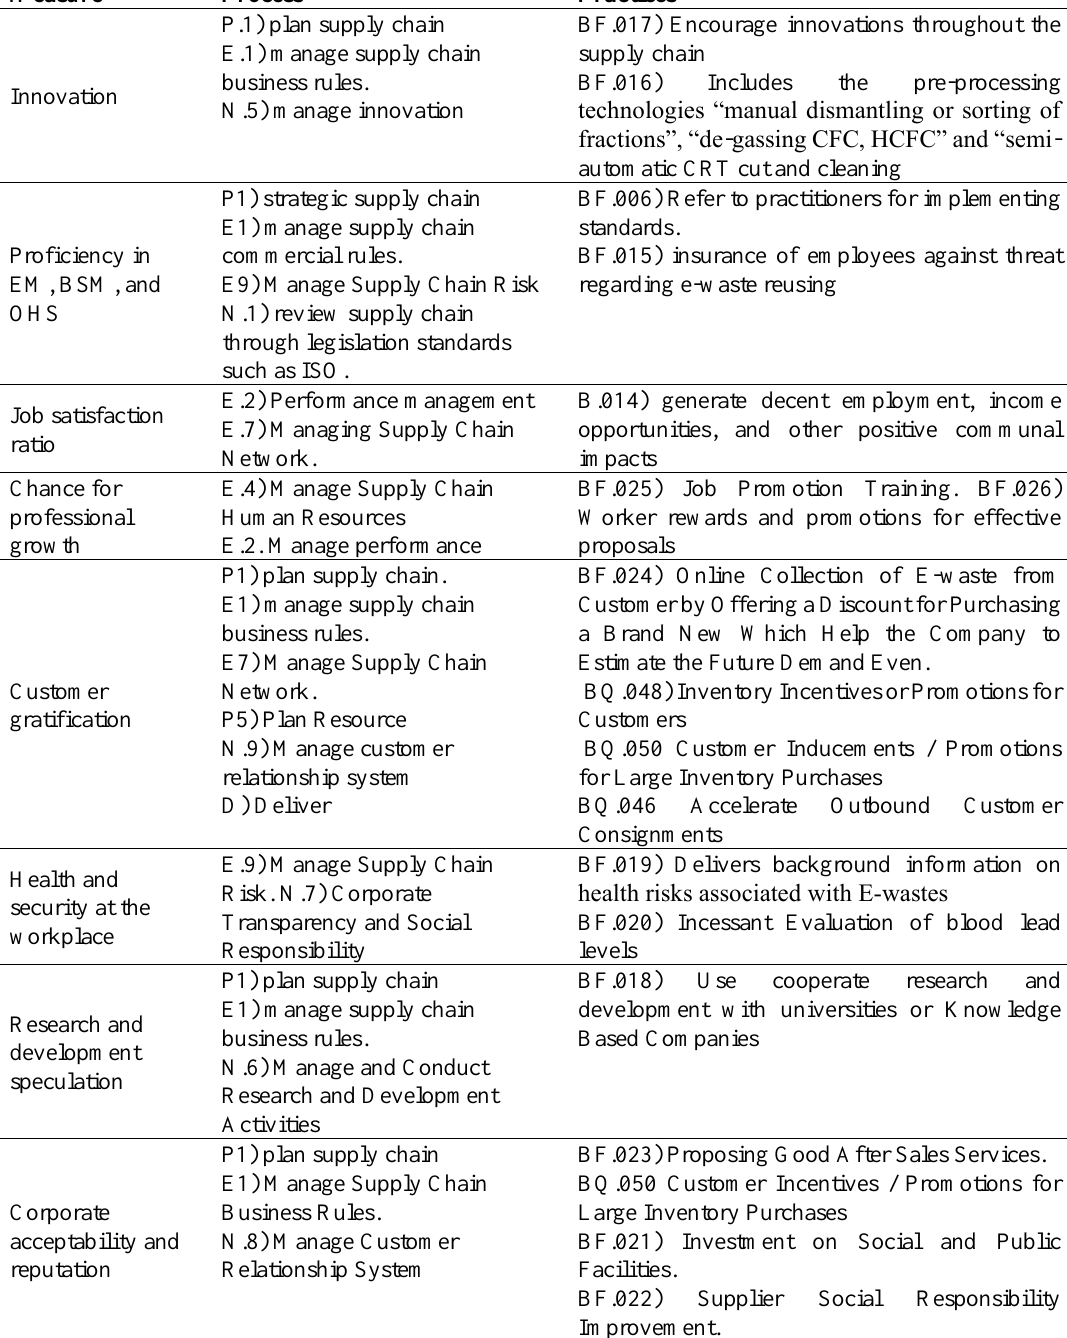
Table.5. The Relation between the New Supply Chain Operation Reference Green Measures with the Procedure and Characteristics of Existing SCOR Degree Measure Process Practices